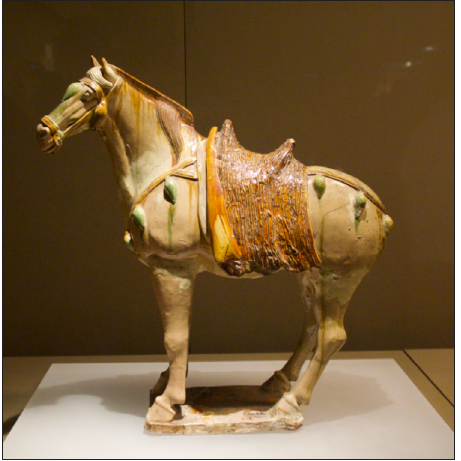
Figure 1: Tang Sancai horse in the Shaanxi History Museum (Photo Shan